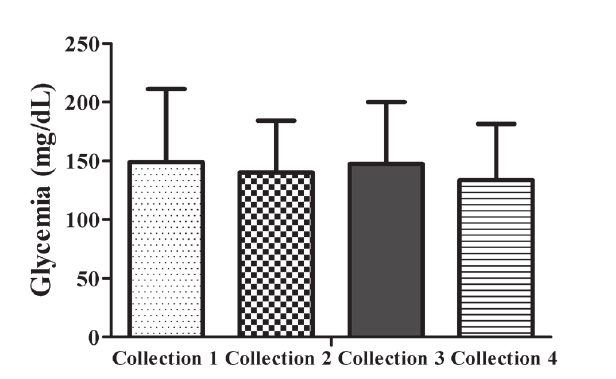
FIGURE 2 - Mean and standard deviation of glycemia of patients between the 1 st to 4 th collection